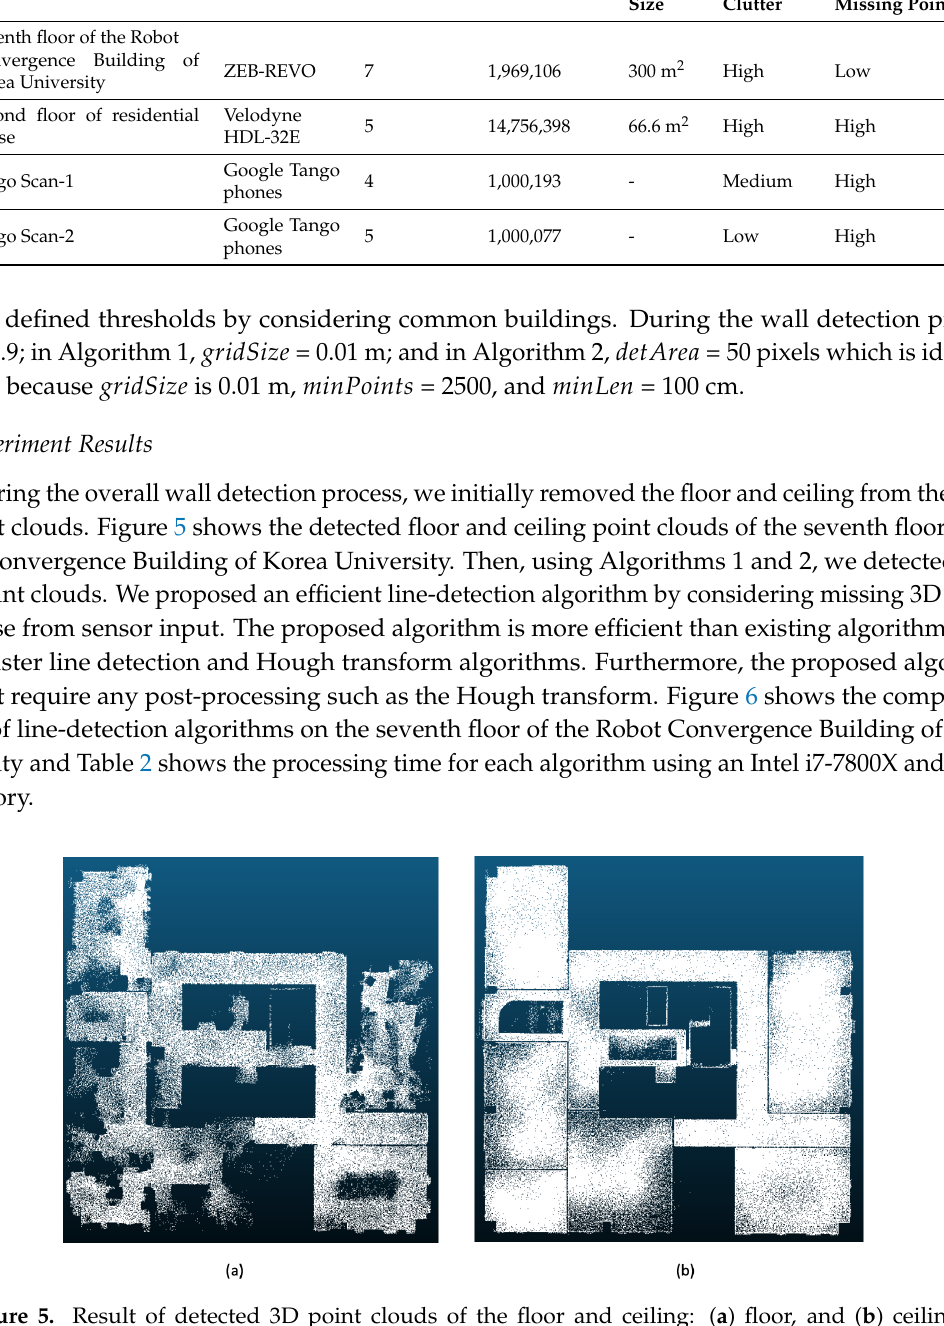
Figure 5. Result of detected 3D point clouds of the floor and ceiling: ( a ) floor, and ( b ) ceiling. Experimented on the seventh floor of the Robot Convergence Building of Korea University